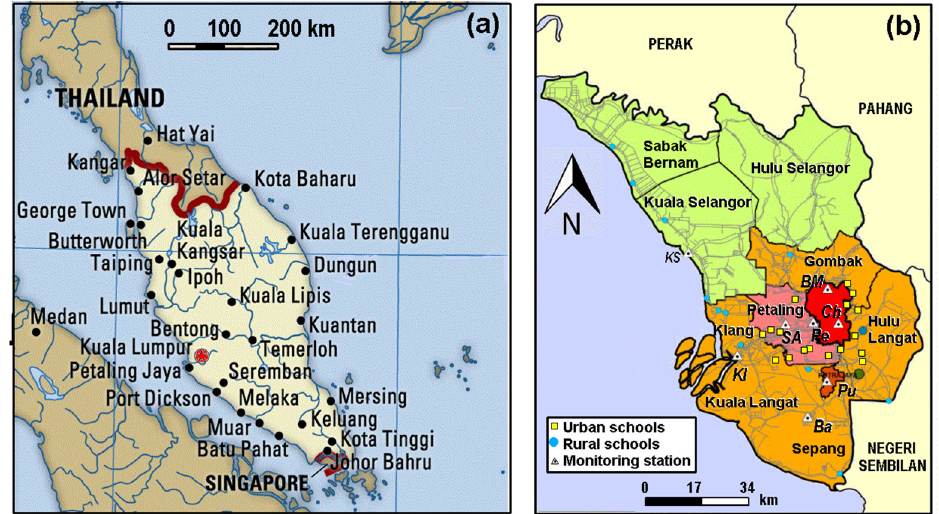
Figure 1. ( a ) Map of peninsular Malaysia, with Kuala Lumpur as a red dot. ( b ) Map showing the State of Selangor with schools from the MIROS report (MIROS 2020), monitoring sites and districts of the State and the two Federal Territories of Kuala Lumpur (red) and of Putrajaya (red-brown). The monitoring sites are coded: Putrajaya (Pu), Petaling Jaya (Pe), Shah Alam (SA), Banting (Ba), Klang (Kl), Cheras (Ch), Batu Muda (BM), and Kuala Selangor (KS). Note: red colours are population densities > 1400 km − 2 , orange > 1000 km − 2 and green > 200 km − 2 .